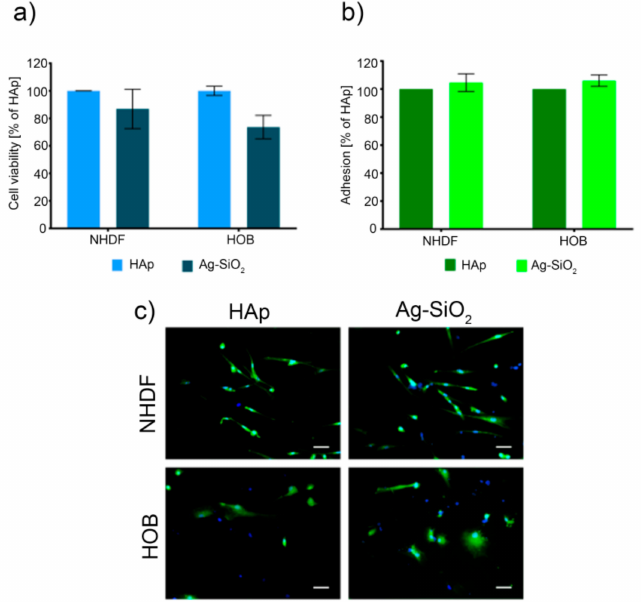
Figure 4. ( a ) Cell viability, ( b ) cell adhesion, and ( c ) cell morphology observed for the hydroxyapatite (HAp) and silver-silica coating (Ag-SiO 2 ) that had functionalized the surface of the NiTi alloy. Scale bar—50 µ m. Normal human dermal fibroblast (NHDF) and osteoblast (HOB) cells were considered during the